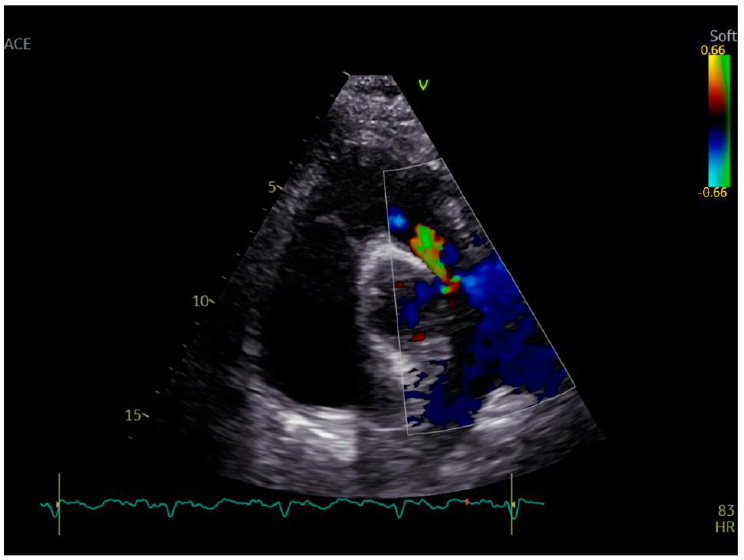
Figure 3. Moderate pulmonary regurgitation.